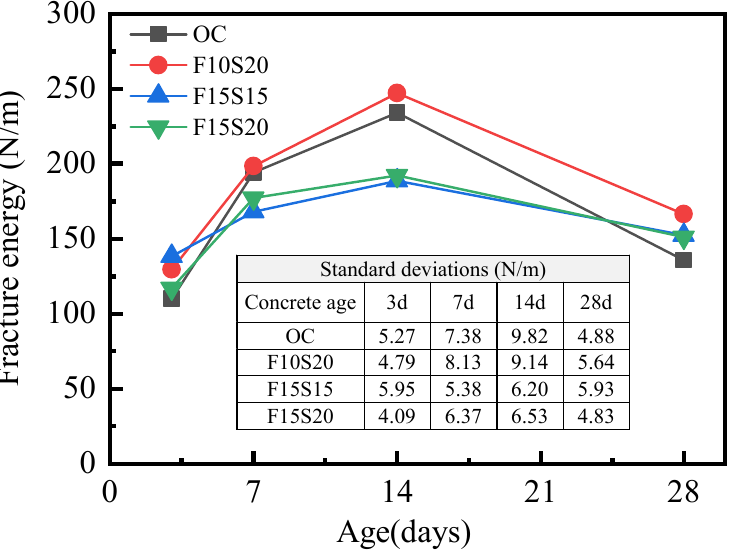
Figure 7. Variation of fracture energy of concrete with curing